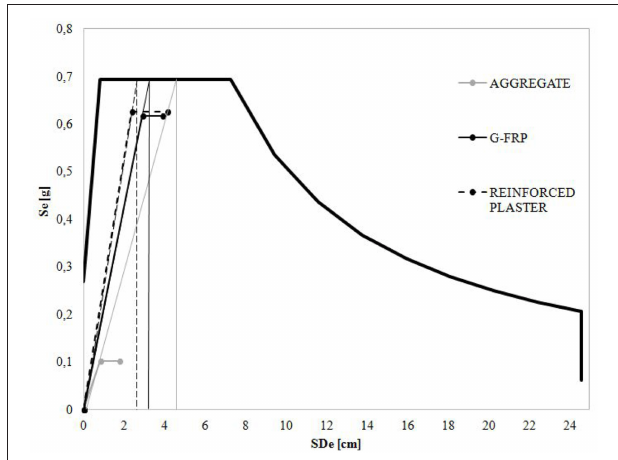
FIGURE 11 | Comparison between capacity curves of the aggregate bell tower in the ADRS format before and after retrofitting